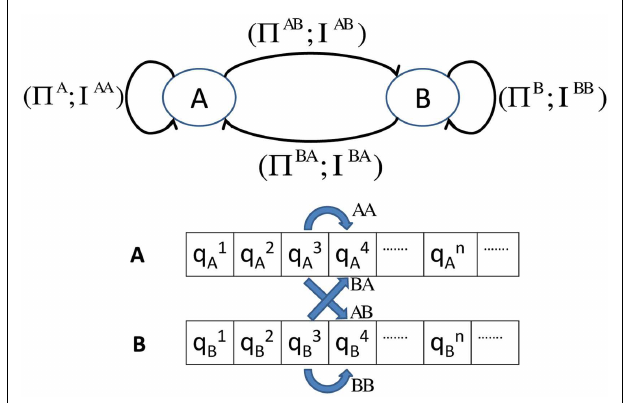
FIGURE 3 | Illustration of Spatiotemporal Pattern Network (STPN)